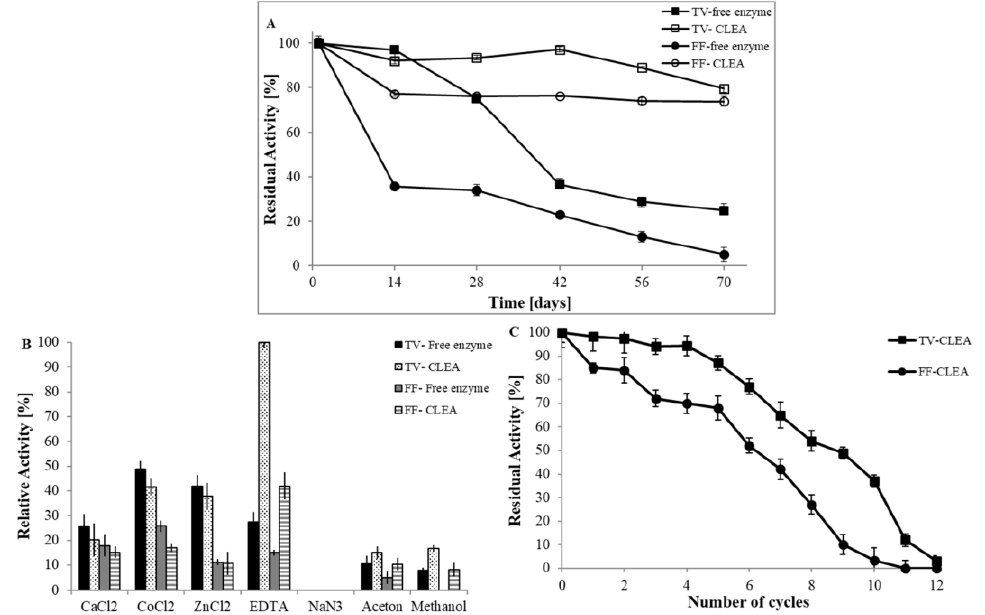
Figure 3. ( A ) Storage stability of free enzyme and CLEA from T. versicolor and F. fomentarius ; ( B ) The relative activity of the free and immobilised laccases incubated with chemical denaturants; ( C ) Operational stability of CLEAs from T. versicolor and F. fomentarius .